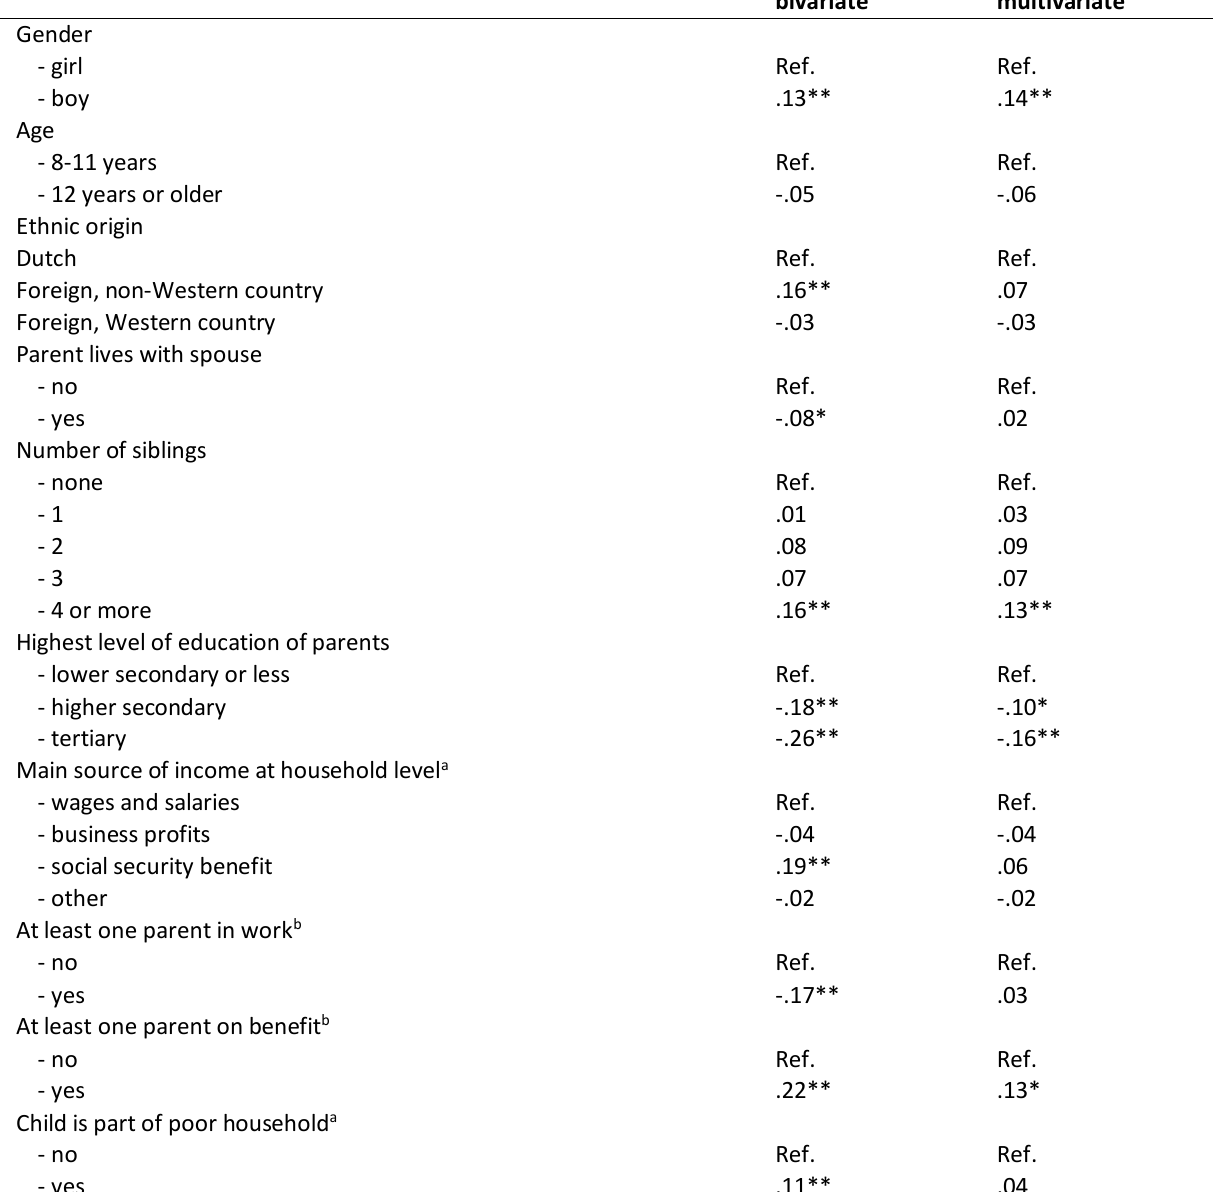
Table 5. Relationships between the general social exclusion scale and various risk factors among Dutch children, 2008 (standardised regression coefficients of dummy variables, weighted